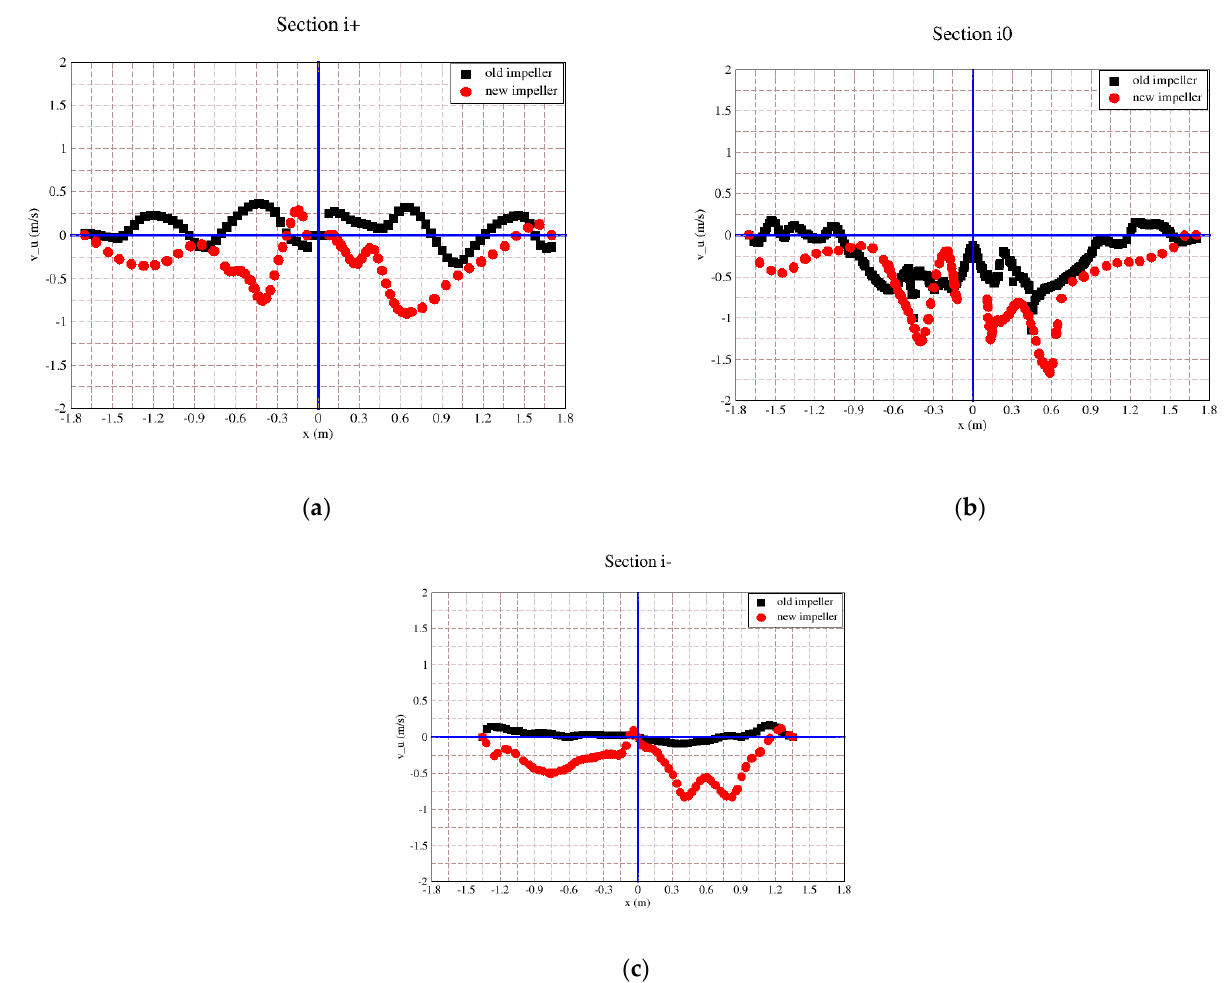
Figure 10. Tangential velocity distribution of the liquid phase at various axial levels, old impeller vs. new impeller: ( a ) above impeller; ( b ) impeller level; ( c ) under impeller.